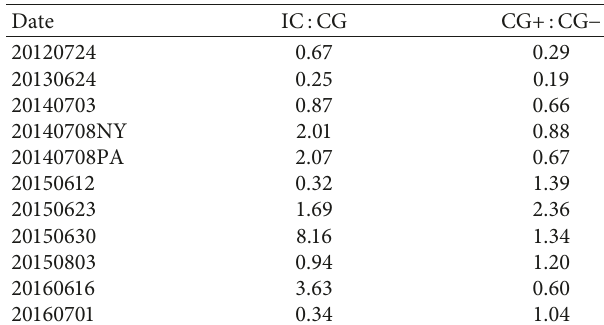
Table 5: Summary of IC :CG and CG+:CG − ratios for microburst events.